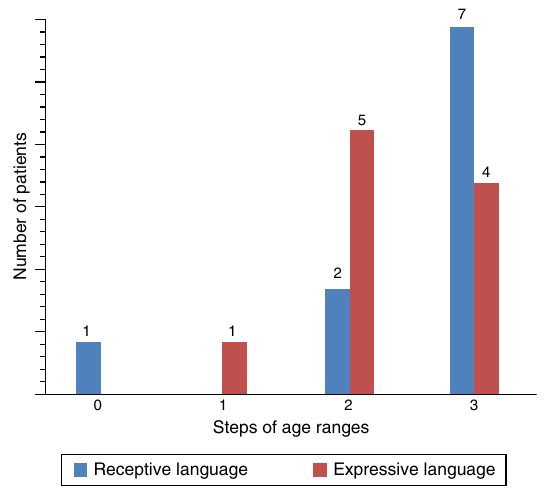
Results of PLS-4 scores in ANSD with CI (PLS-4 scores were shown as progress in age range by